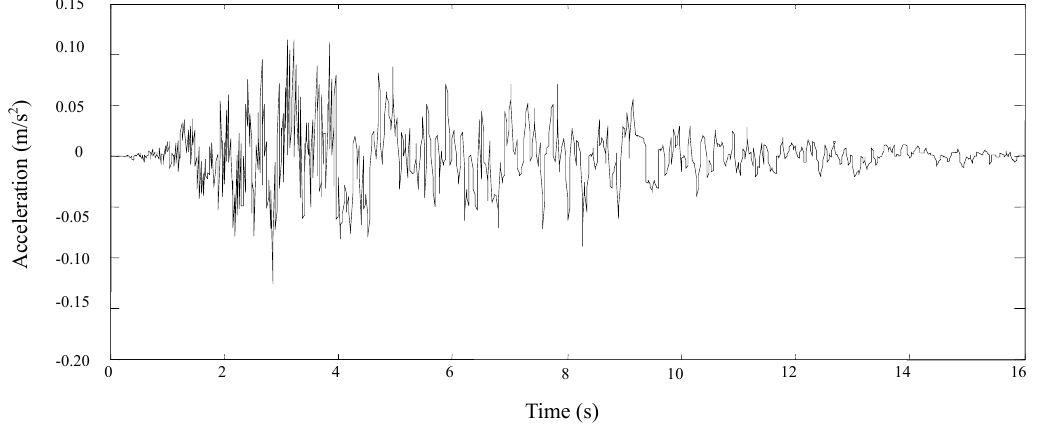
Fig. 7. type II site synthesize seismic acceleration time-history.